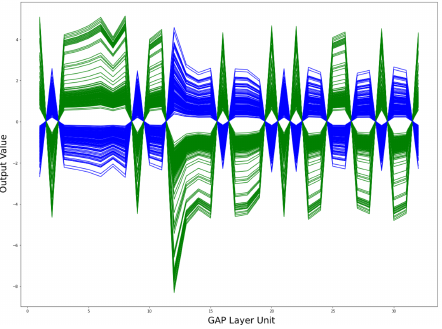
Figure 8. Global average pooling layer output providing the training test as model input. For both classes (i.e., FNS and nFNS) every sample is correctly classified. In this case no overlapped lines are visible between the two groups of lines (i.e., green or blue). Each line corresponds to an author.